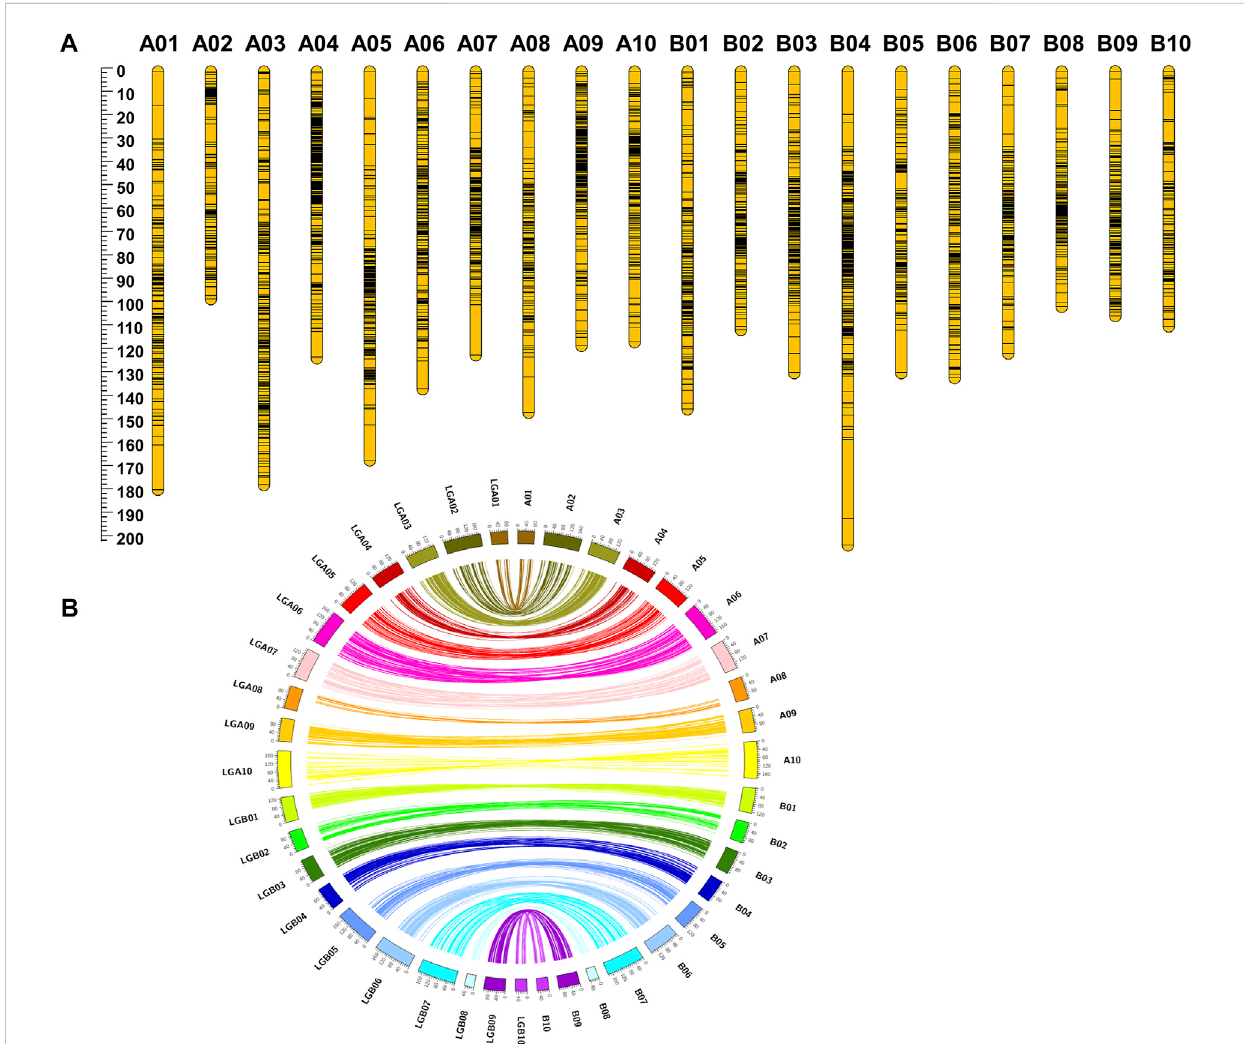
FIGURE 2 Highlycollineargeneticmapconstructed usingRILpopulationChico×ICGV02251. (A) SNPlocidensity onthe20linkagegroups. (B) Collinearity of the genetic map with the physical